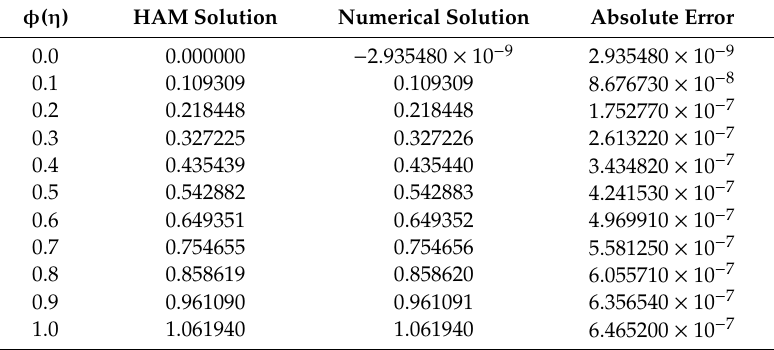
Table 6. Comparison of HAM and numerical solution for φ ( η